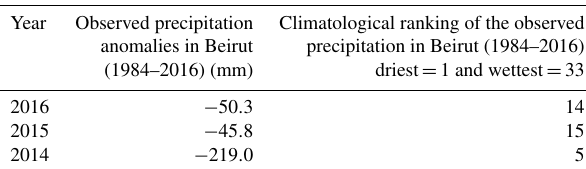
Table 2. Precipitation anomalies in Beirut (1984–2016). Observed precipitation anomalies in Beirut (20ma.s.l) are based on AWS me- teorological data provided by the national civil aviation